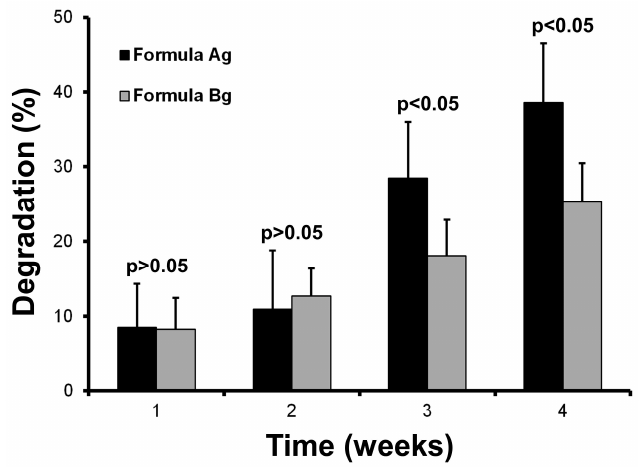
Figure 7. In vitro biodegradation of scaffolds.